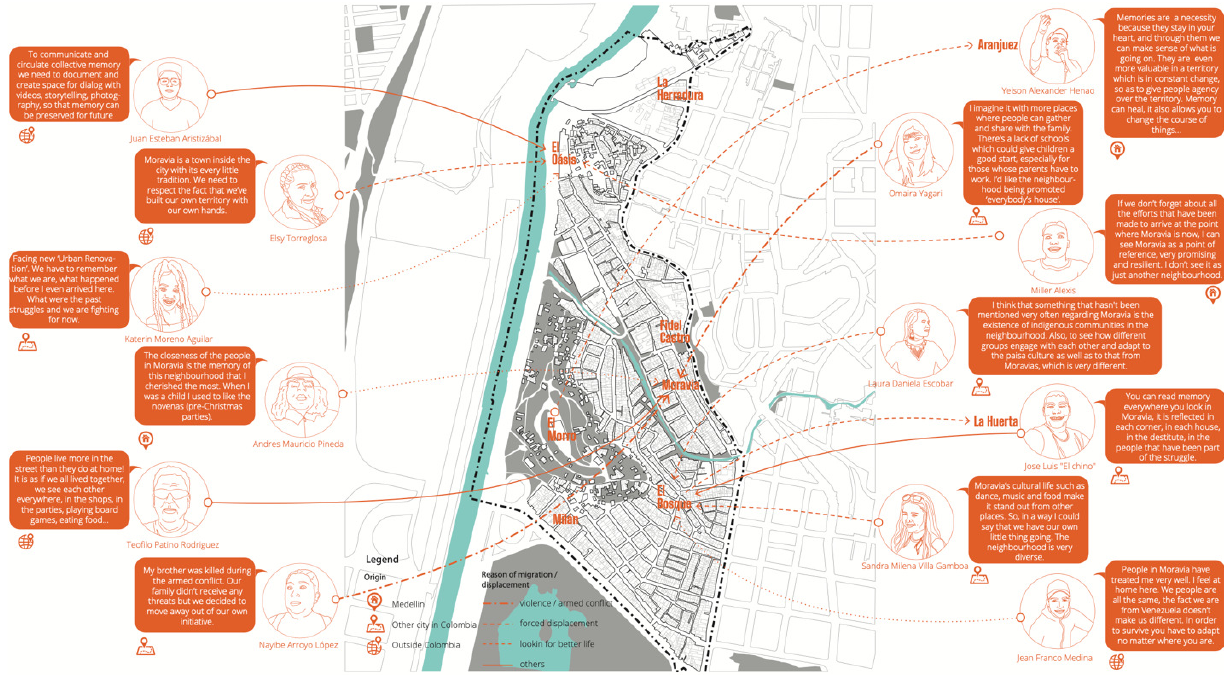
Figure 2. Life stories of migration. Source: Drawn by Memory and Migrations Team cohort 2019–2020 for Atlas of Living Heritage.